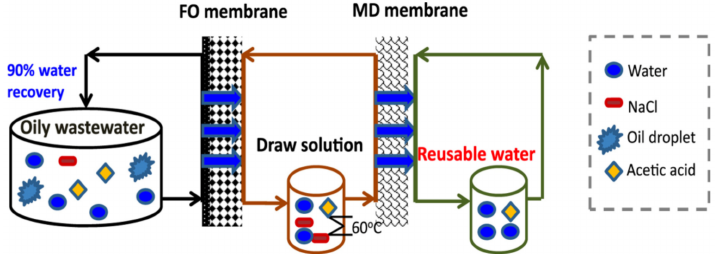
Figure 5. Schematic diagram of combination of forward osmosis (FO) and membrane distillation (MD) for wastewater treatment